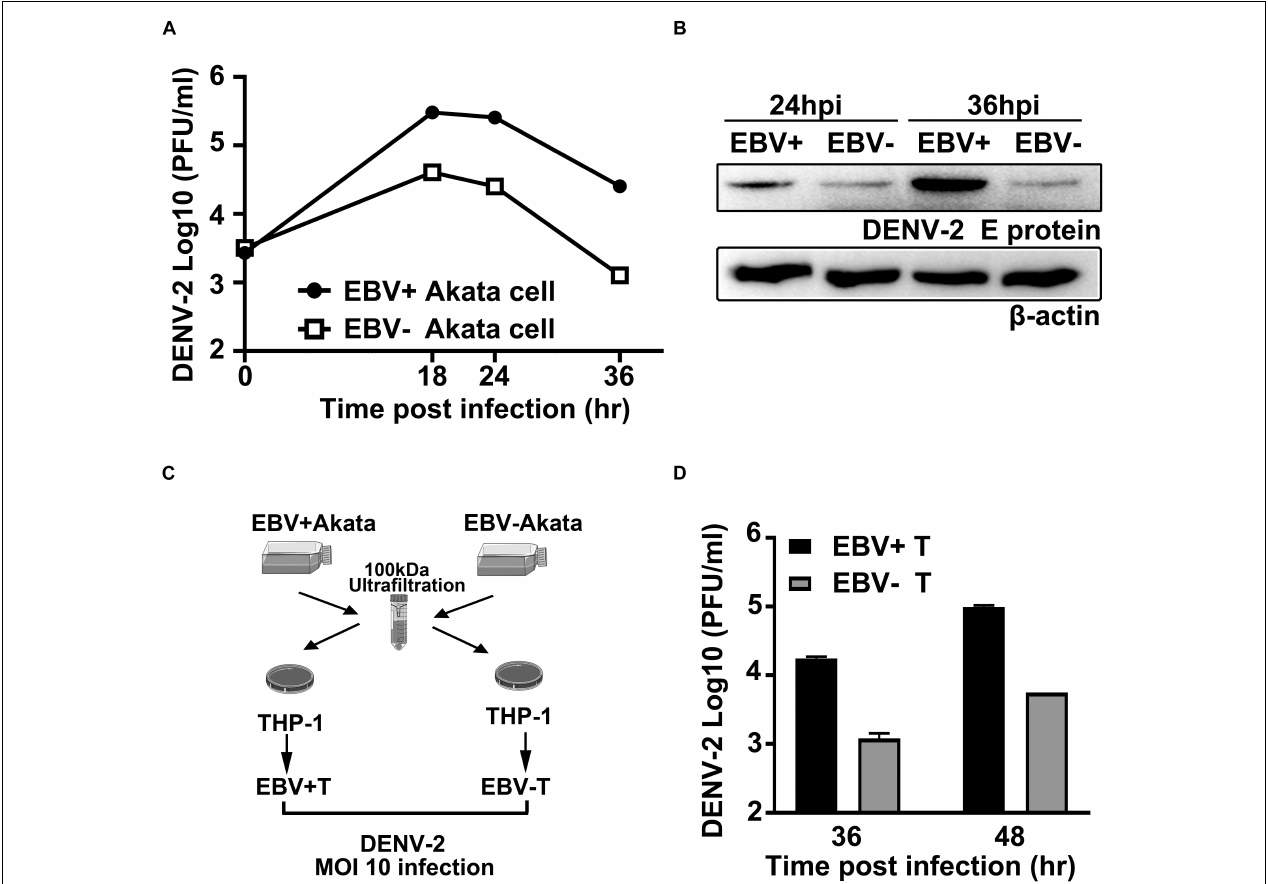
FIGURE 4 | Preexisting Epstein–Barr virus (EBV) infection facilitates DENV-2 propagation in Akata and THP-1 cells. (A,B) Equivalent amount of EBV + Akata or EBV- Akata cells were mock-infected or infected with DENV-2 at a multiplicity of infection (MOI) of 10. Growth kinetics of DENV-2 were determined by plaque assay and plotted as in panel A . DENV-2 E protein expression level at 24 and 36 hpi was quantified by immune blot (B) . (C) Schematics illustration of the experimental workflow. Low-molecular weight fractions ( < 100 kDa) of the culture supernatants from EBV + and EBV- Akata cells were incubated with THP-1 cells for 8 h. Differently primed THP-1 cells were referred to as EBV + T and EBV- T, respectively, in panel D . (D) The primed THP-1 cells were then infected with DENV-2 at a MOI of 10, and DENV-2 titers in the culture medium at 36 and 48 hpi were determined by plaque